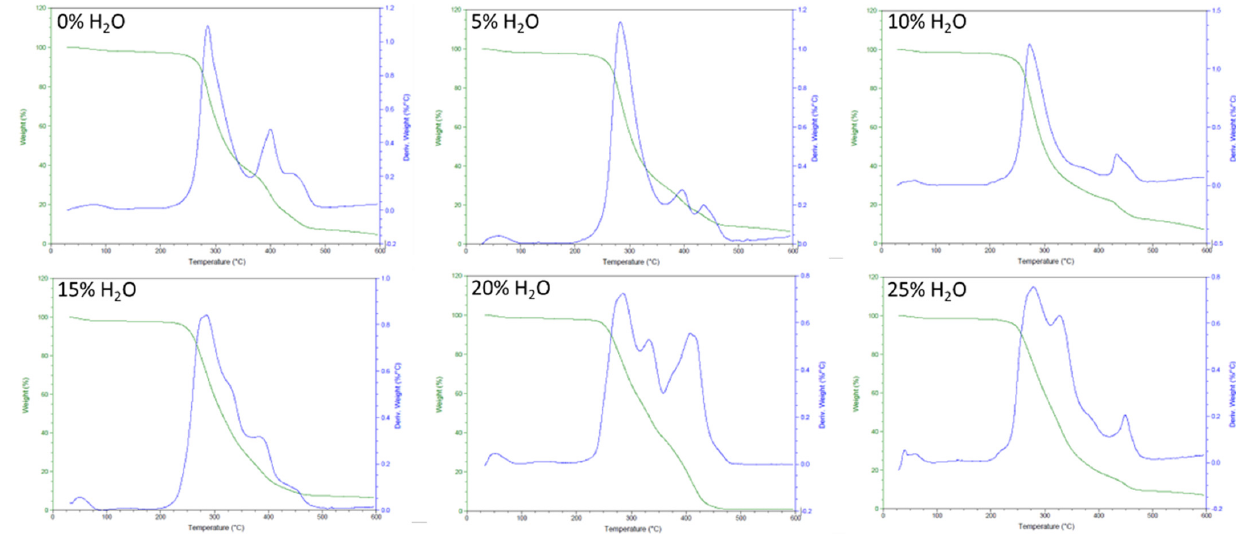
Figure 4. TGA thermogram of SMP foams with varying water content.